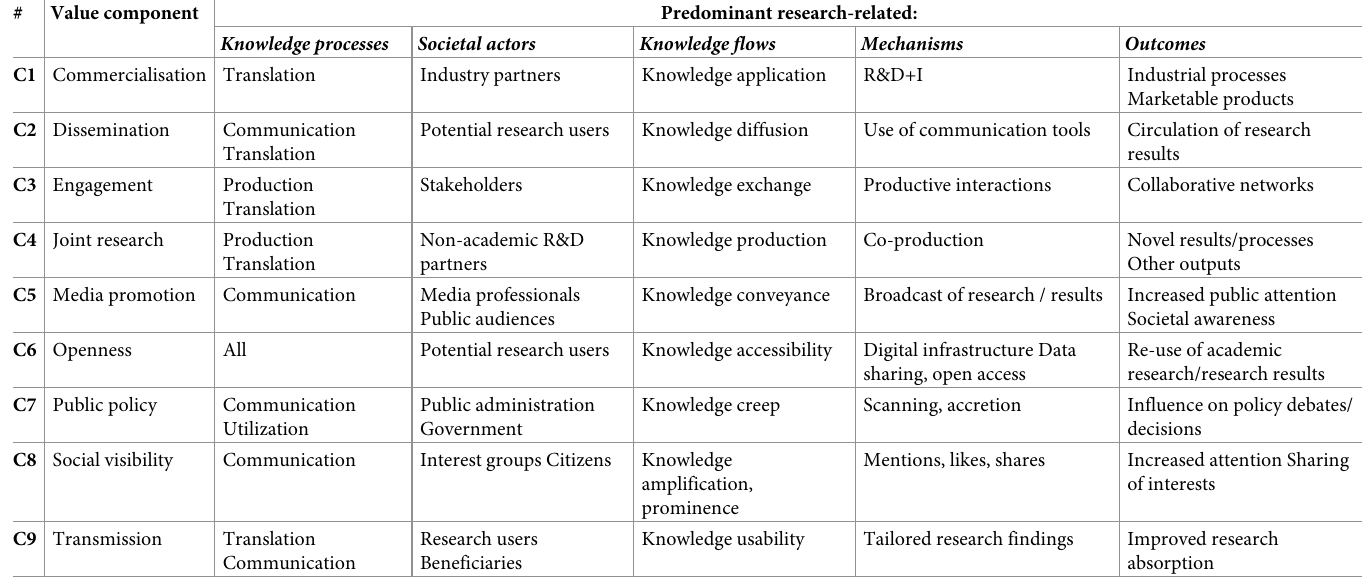
Table 3. Characteristics of each component in our value